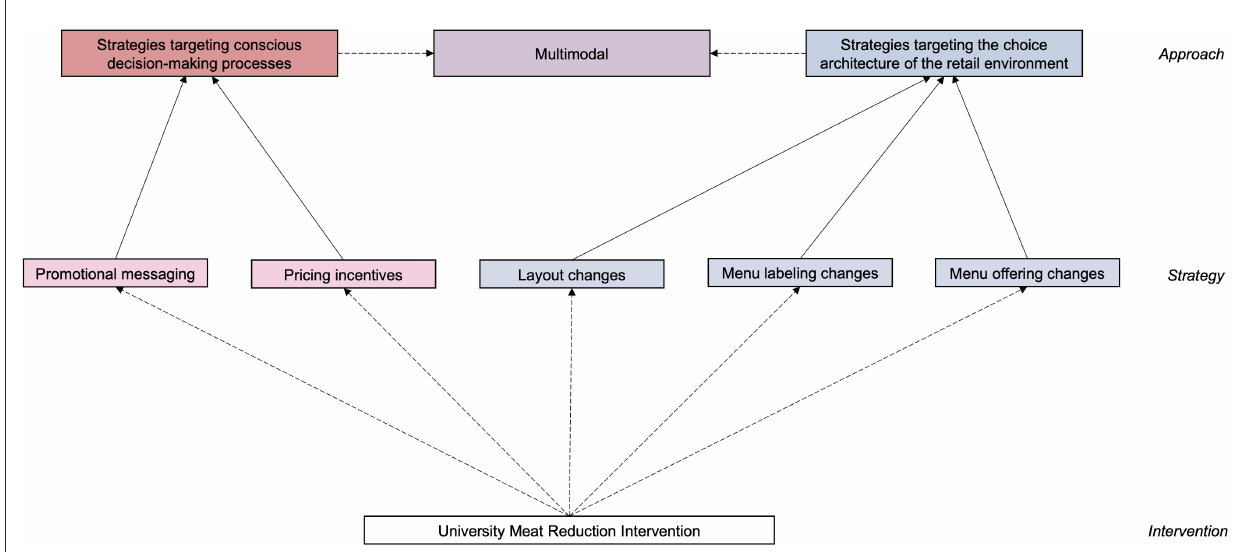
FIGURE1 Flow diagram outlining the organizing principles of our intervention classification scheme. Interventions are considered “multimodal” if they involved two or more strategies corresponding to each of the remaining two approach styles. Therefore, at minimum, multimodal interventions must include at least one strategy targeting the choice architecture of the retail environment and at least one strategy targeting conscious decision-making